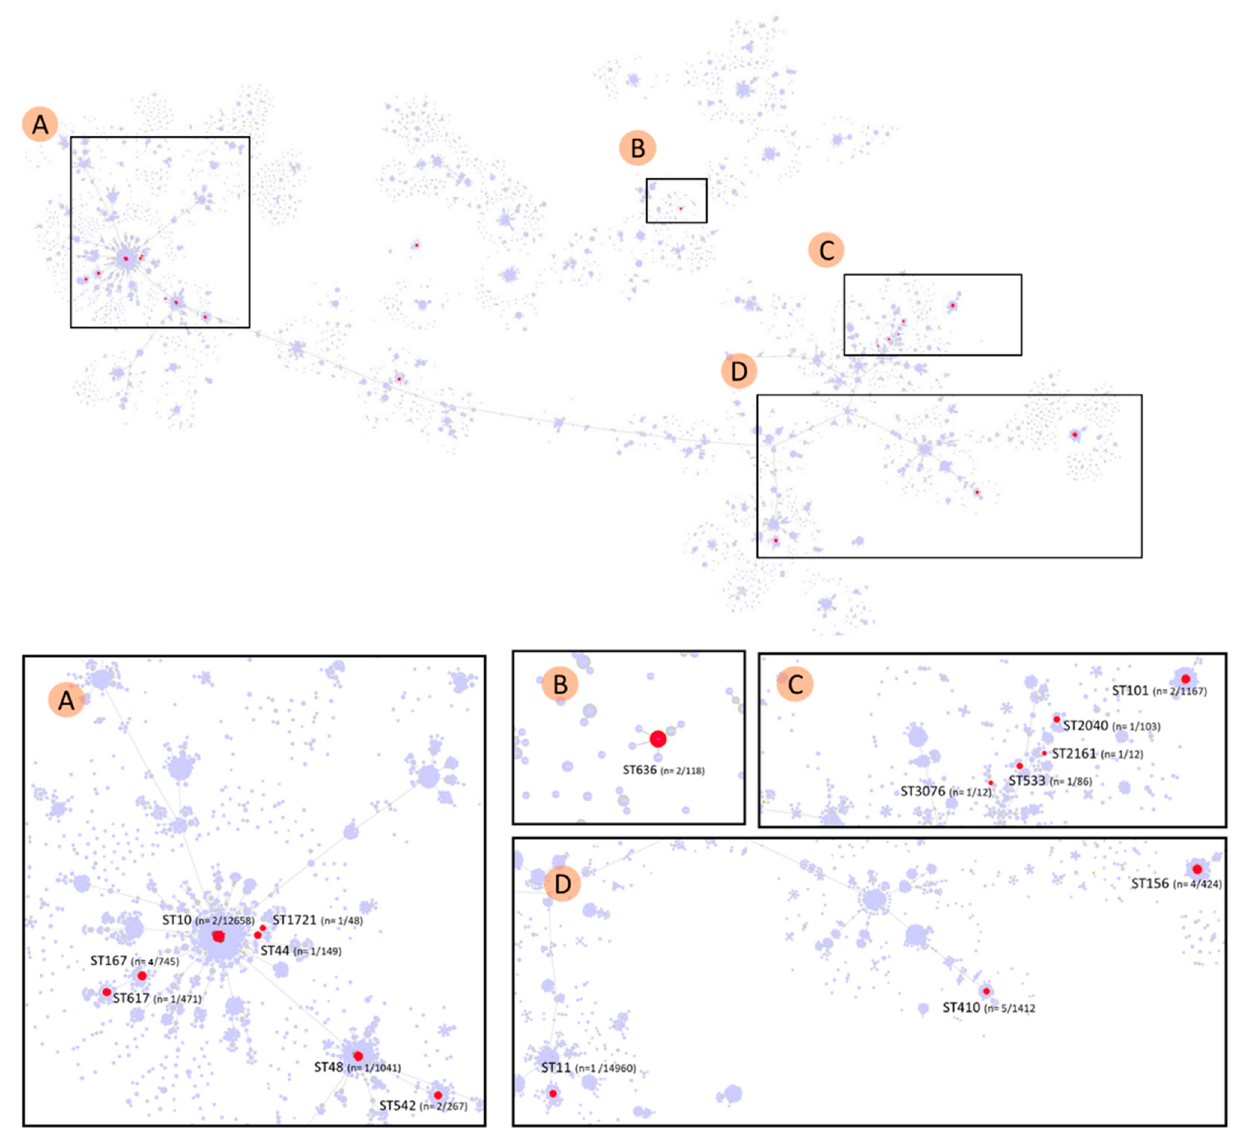
Figure 2. goeBURST diagram of E. coli genomes carrying a bla NDM-5 encoding IncX-3 plasmid within a global population of E. coli established on 178 776 strains available in the EnteroBase database. Each node corresponds to a Sequence Type (ST). The size of the node is scaled to the number of genomes of that ST. Nodes linked between them present one allele in common among the 7 genes considered in the MultiLocus Sequence Type scheme. Red nodes correspond to STs for which genomes with a bla NDM-5 encoding IncX-3 plasmid was identified; the proportion in the ST of genomes containing the plasmid is noted in